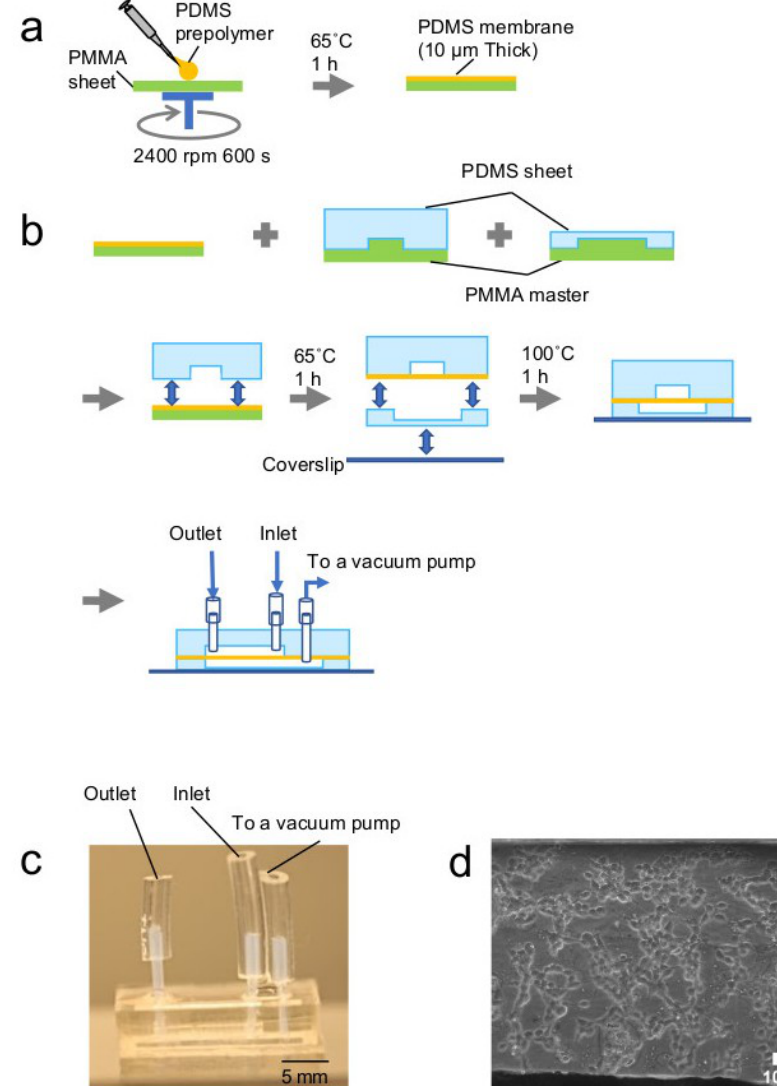
Figure 1. Device fabrication. ( a ) A poly(dimethylsiloxane) (PDMS) membrane (10 μm thick) was fabricated by spin coating a PDMS prepolymer on a Polymethyl methacrylate (PMMA) substrate. ( b ) Illustration of the device assembly and tube connection process. ( c ) Photograph of the device. ( d ) Phase contrast image of normal pulmonary artery smooth muscle cells (PASMCs) in a microchannel.